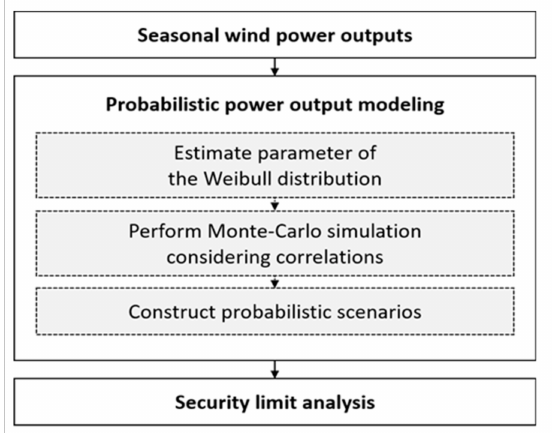
Figure 1. Process of the power grid security limit analysis considering probabilistic output